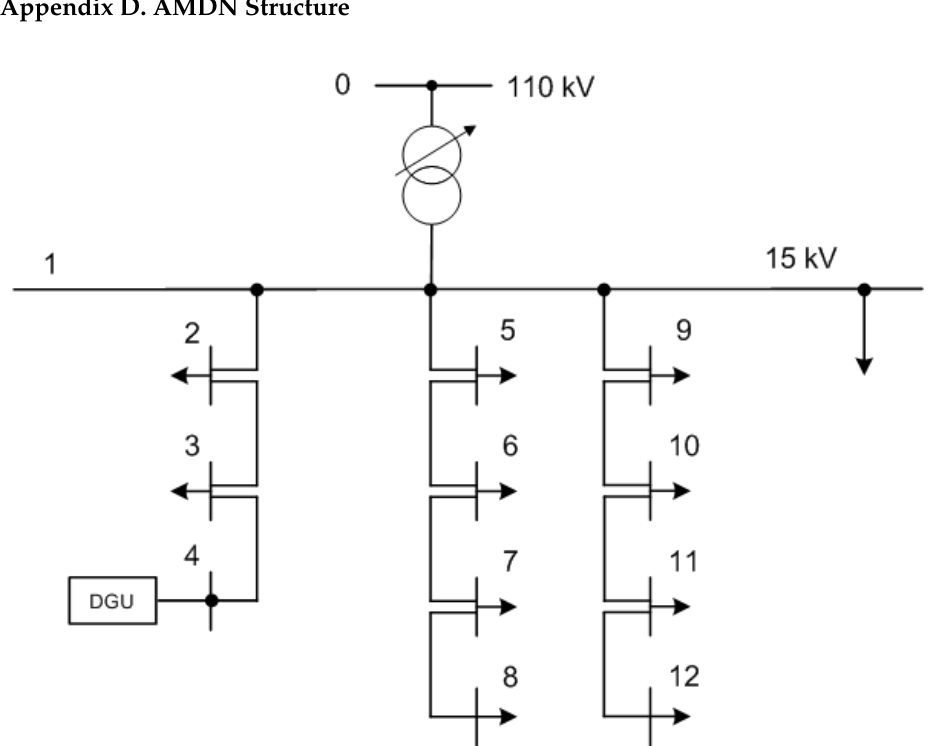
Figure A5. Actively managed MV distribution network with the DG unit (based on [84]). Table A7. Energy consumers connected to the actively managed MV distribution network. Node No.